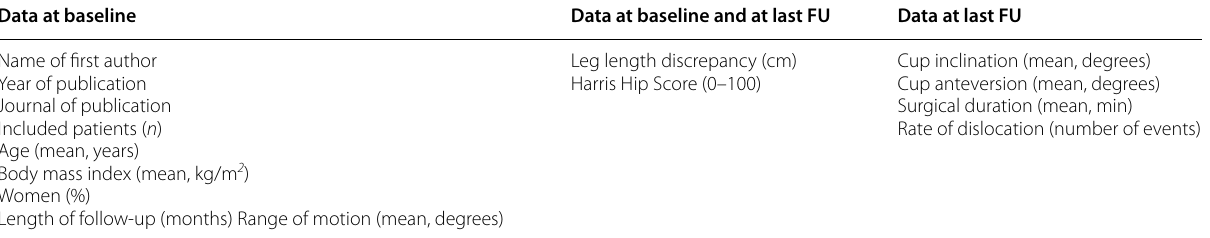
Table 1 Typology of data extracted at baseline, baseline and last follow-up (FU), and last FU Data at